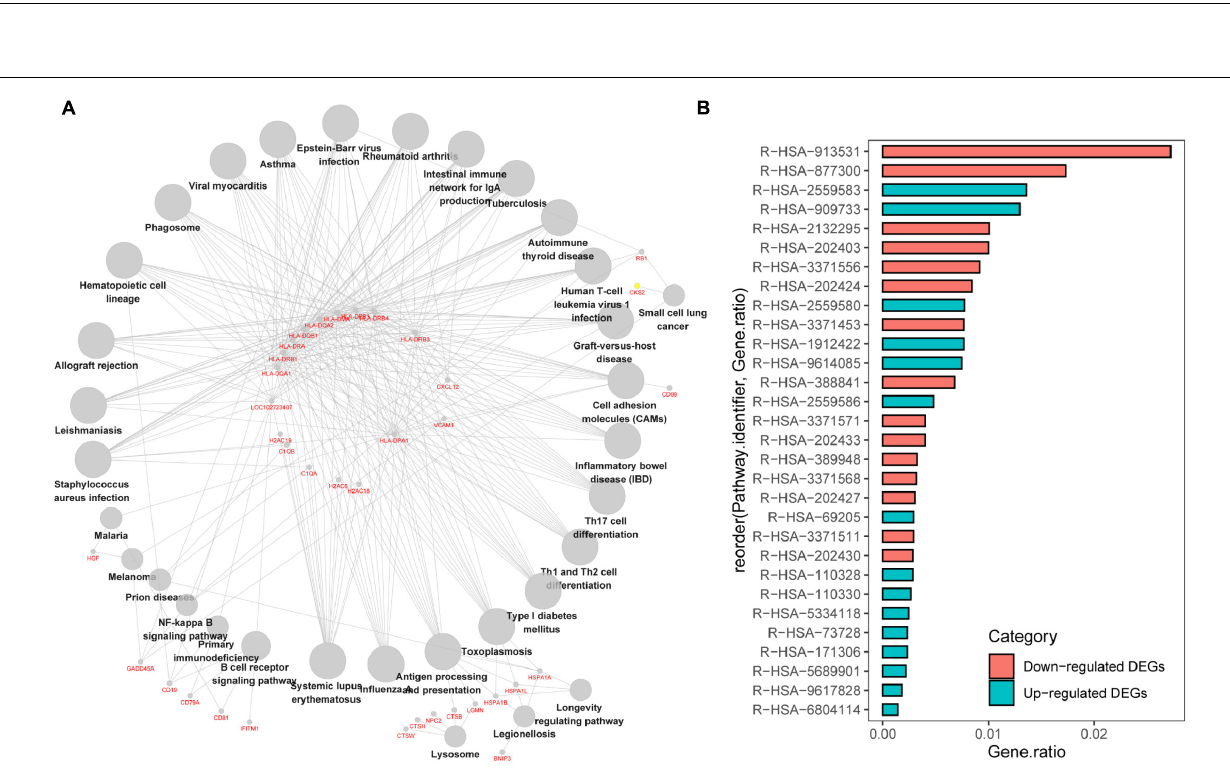
Frontiers in Genetics |